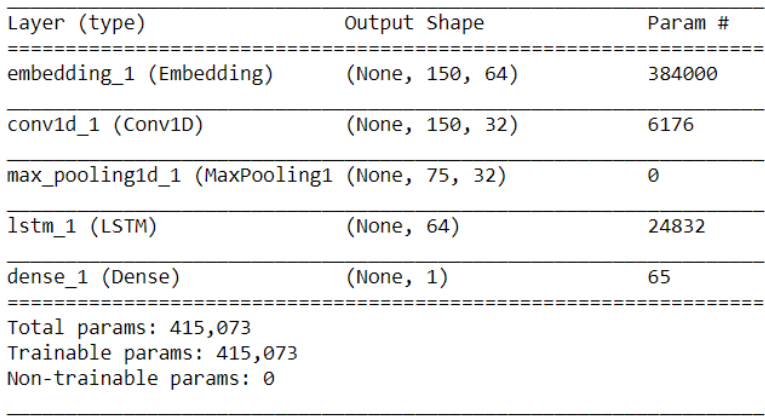
Figure 7. Parameters of CNN-LSTM